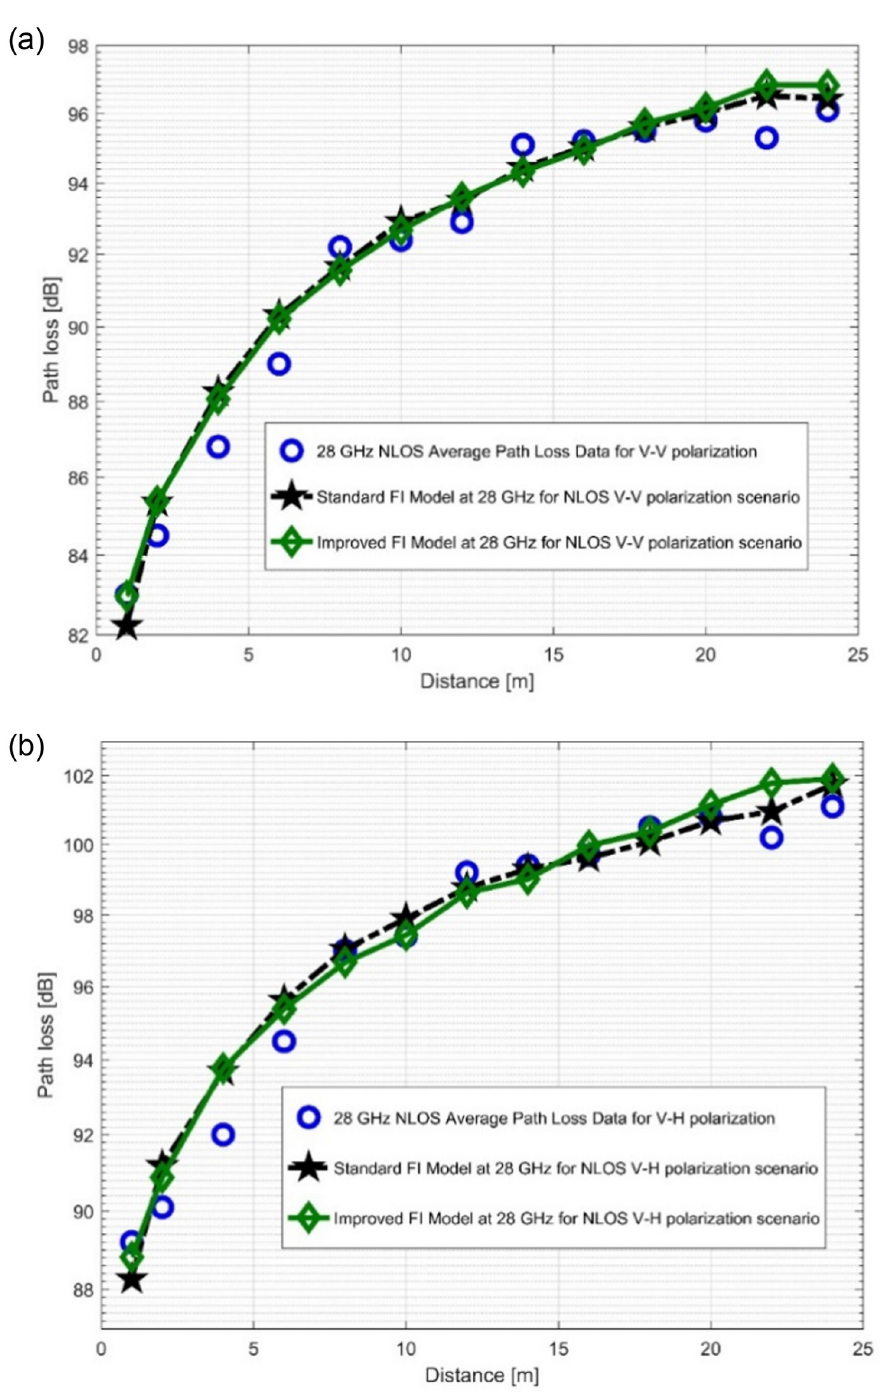
Fig 14. PL vs distance at 28 GHz for the NLOS scenario at (a) V-V polarization, (b) V-H polarization. improved FI model. The improved CI model for V-V polarization gives 1.9294 dB which is noted for the MPE’s best performance at the 38 GHz FB. The improved FI model provides an increase in the PE value for both polarizations, but not quite to the same extent as of the improved CI model.